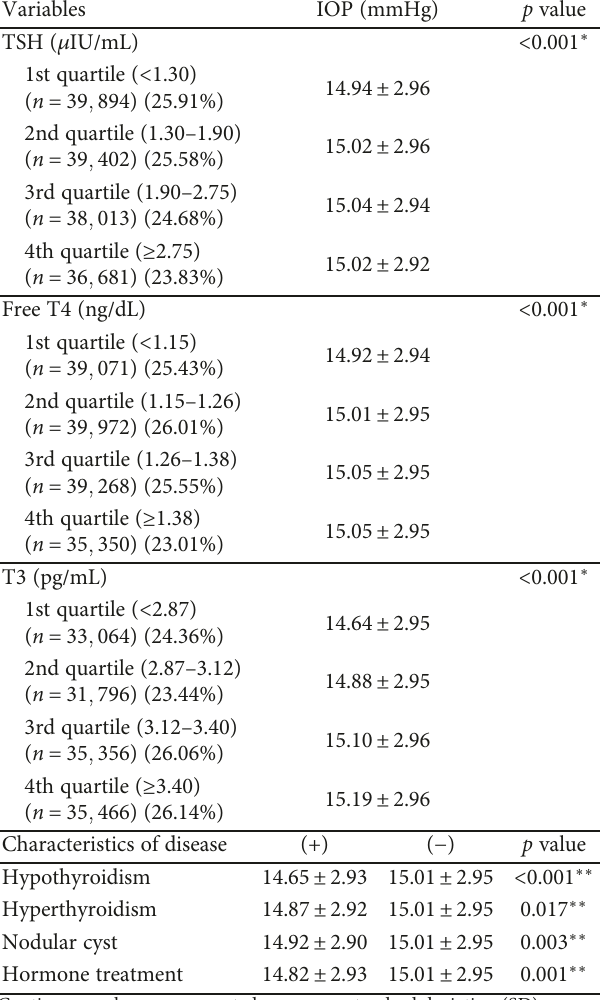
Table 3: Univariate analysis of thyroid function and IOP in a normal population without glaucoma.